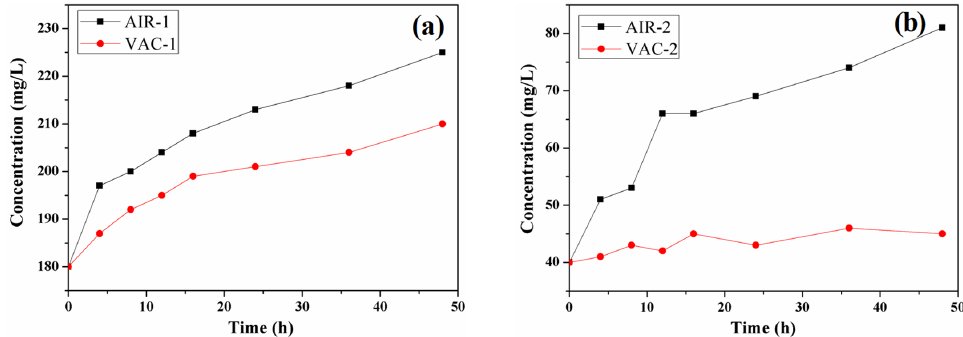
Figure 6. Concentration of arsenic with respect to time in different atmospheres: ( a ) the raw acid ASS in air and vacuum; ( b ) the eluted ASS in air and